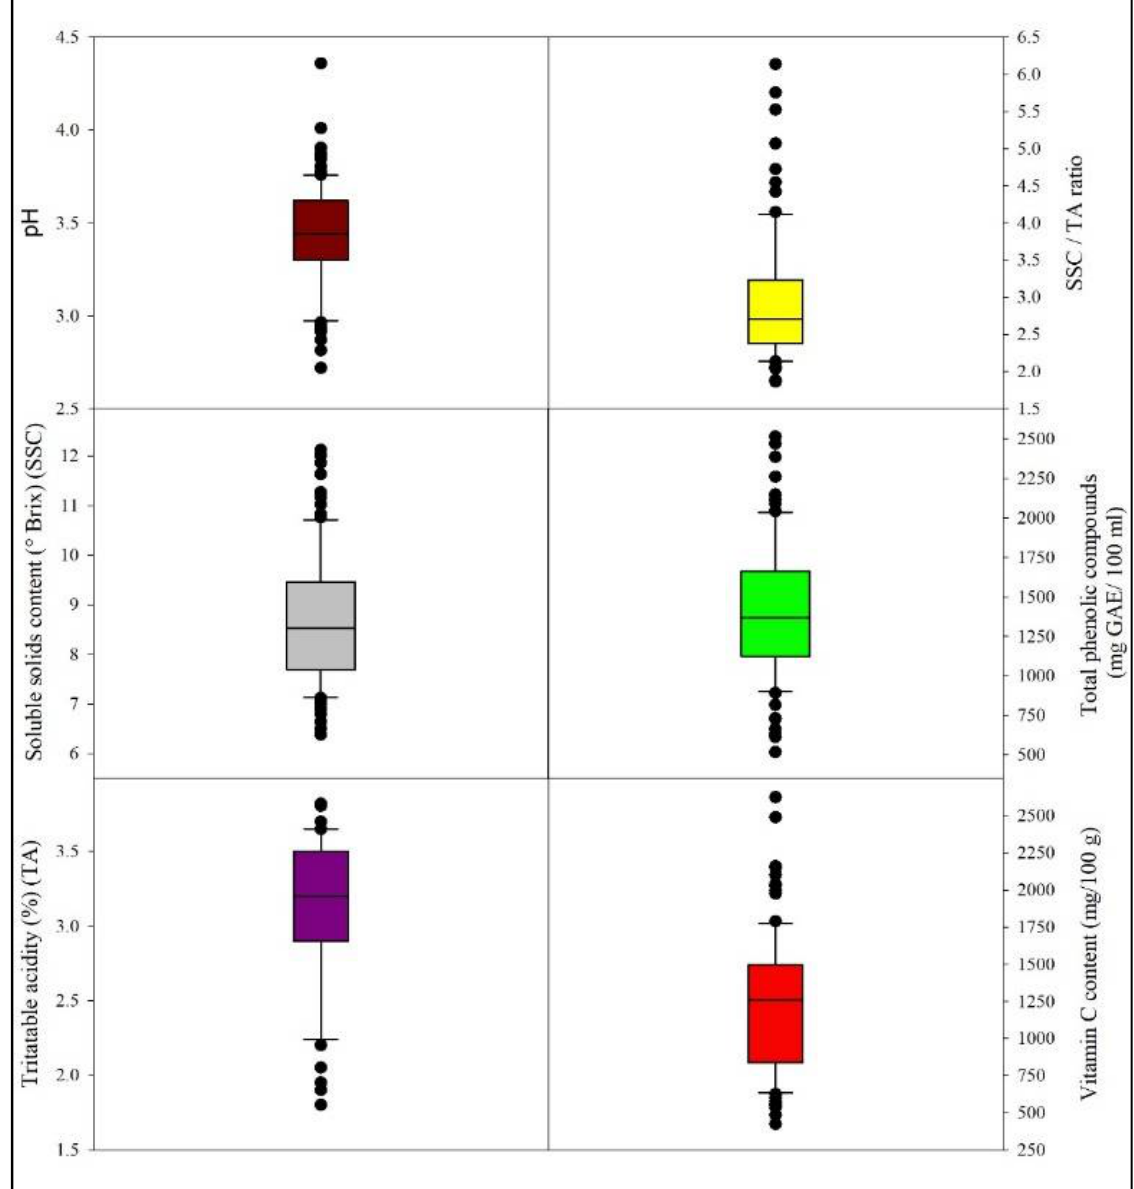
Figure 4. Box plots of chemical parameters. Whiskers (error bars) above and below the box indicate the 90th and 10th percentiles. The horizontal line shows the median value. Symbols display extreme data points. Each dot represents the mean value of four replicates of five fruits each.